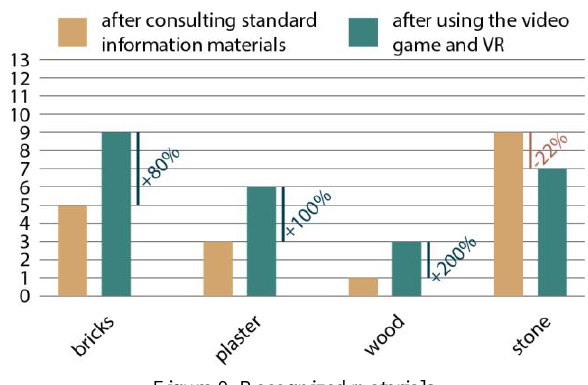
Figure 9. Recognized materials